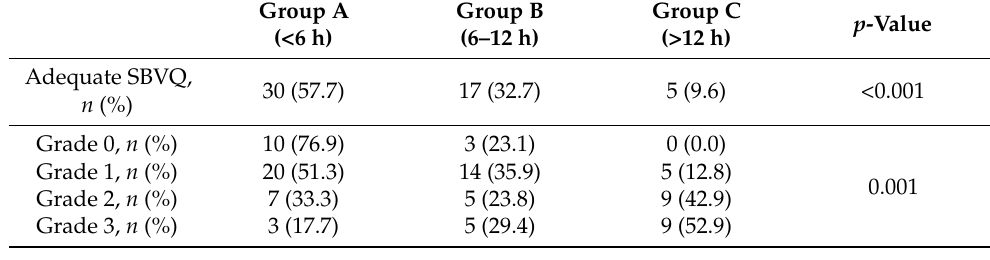
Table 5. Percentage of patients with adequate small bowel visibility quality (SBVQ) and mean SBVQ according to the timing of bowel preparation.